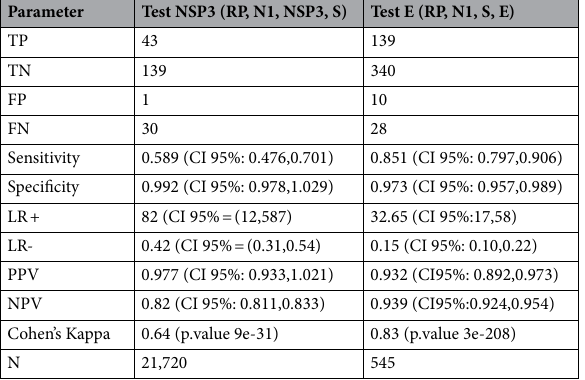
All target genomes were subdivided into kmers of length 19 to 31 with a sliding window of 1. For target genome X and kmer size 19: kmer 1 contained nucleotides from position 1 to position 19, kmer 2 contained nucleotides from position 2 to position 20, and so on. For each group (environmental sequences, SARS-CoV-2 population genomic sequences, or lineage-specific SARS-CoV-2 genomic sequences), the frequency of all observed kmers was calculated using Jellyfish v1.1.12 19 . In this step, a Jellyfish database storing kmer frequen-